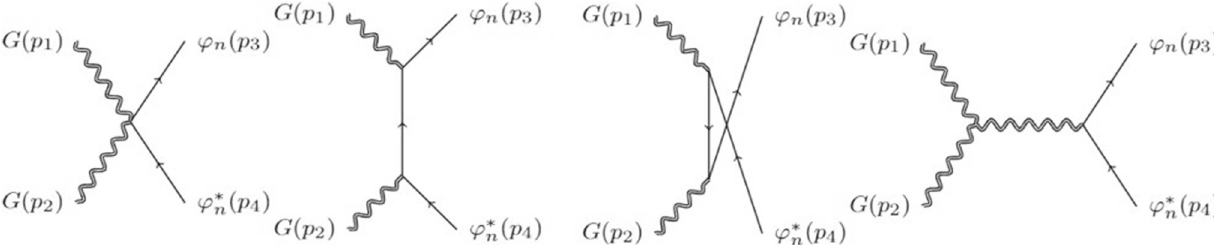
Fig. 5 Feynman diagrams for the production of a pair of matter states from two